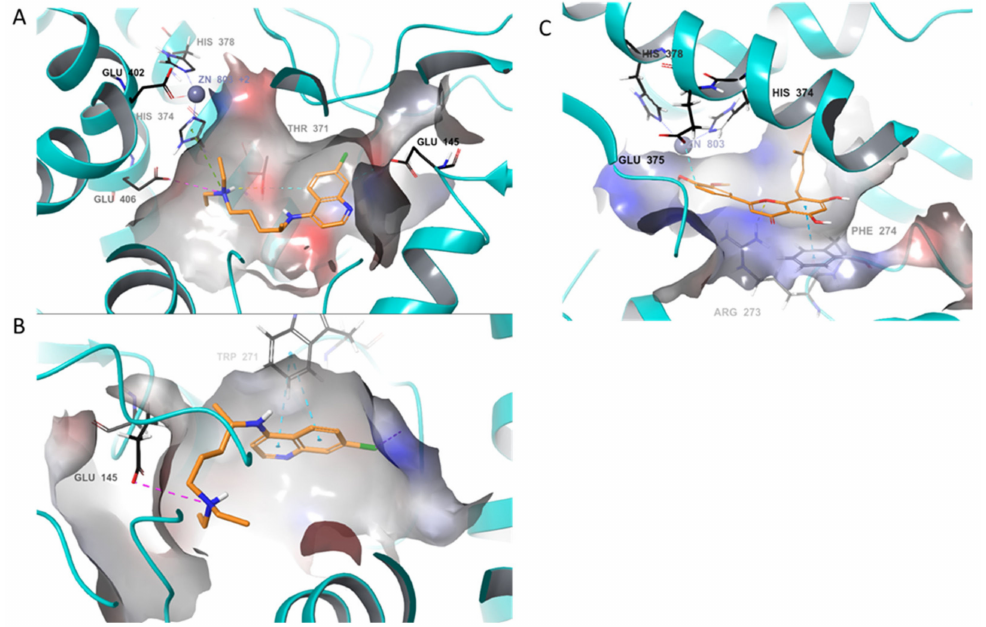
Figure 3. Predicted binding poses of caflanone and chloroquine (CLQ) within the zinc metallopeptidase domain of ACE2 (cyan cartoon and electrostatic potential surface). ( A , B ) Two predicted poses of CLQ (orange), one of which interacts with HIS374, which is coordinated with Zn and the other binds further into the cleft of the catalytic domain, away from Zn. ( C ) Caflanone (orange) is predicted to bind within the catalytic domain similar to CLQ in